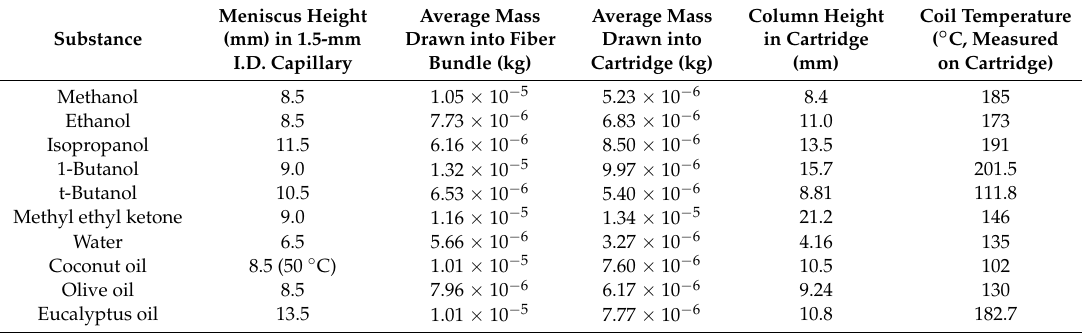
Table 2. Summary of information on substances testing with the porous network/coil systems. Substance